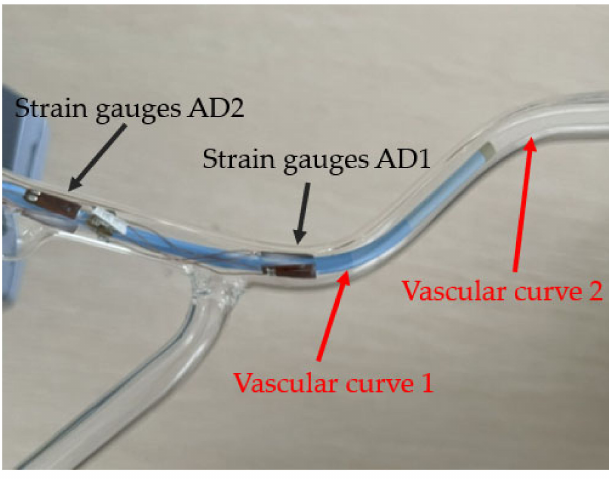
Figure 11. The catheter in blood vessel model.